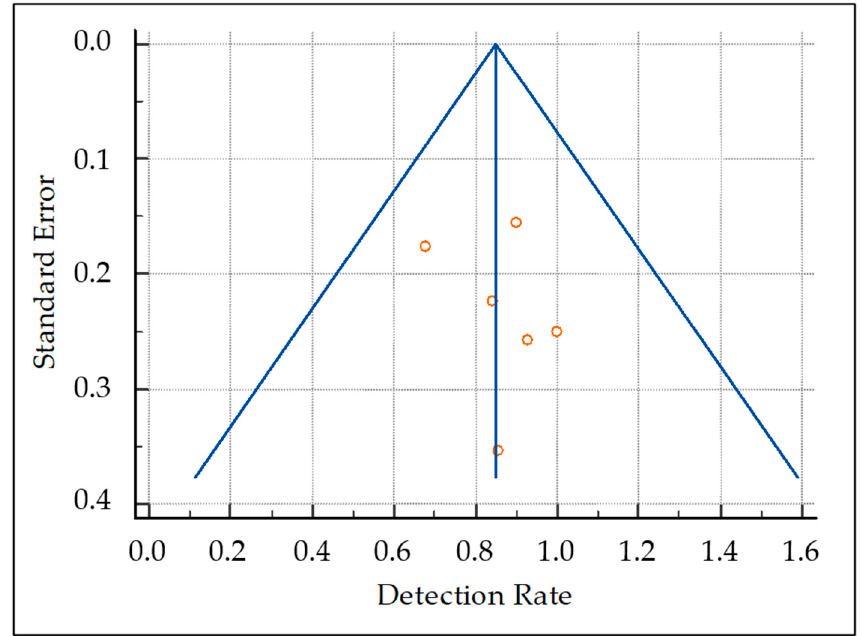
Figure 4. Funnel plot for publication bias assessment. The presence/absence of publication bias is judged taking into account the asymmetric/symmetric distribution of studies (red circles) in the funnel plot.